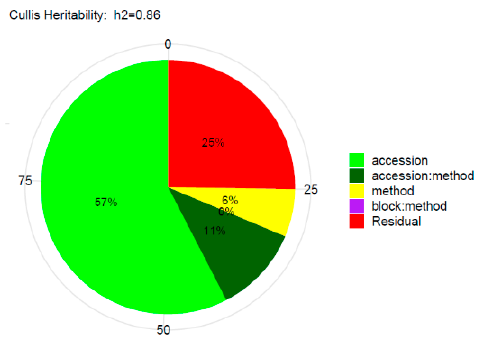
Figure 6. Display the extent of variance components influencing the responses to P. xanthii Race 2 analyzed over both methods. The accession covers with 57% most of the variance, followed by the residual variance with 25%. The interaction between accession and method explains 11% and the method effect 6%. 0% of the total variance is captured by the design effect block:method. When analyzing variance components separately for each method (Figure S2), it becomes clear that artificial inoculation in the growth chamber had a larger genetic variance (81%) than natural infection in the greenhouse (67%). The residual component, which might refer to other environmental effects, was higher under natural infection (33% vs.